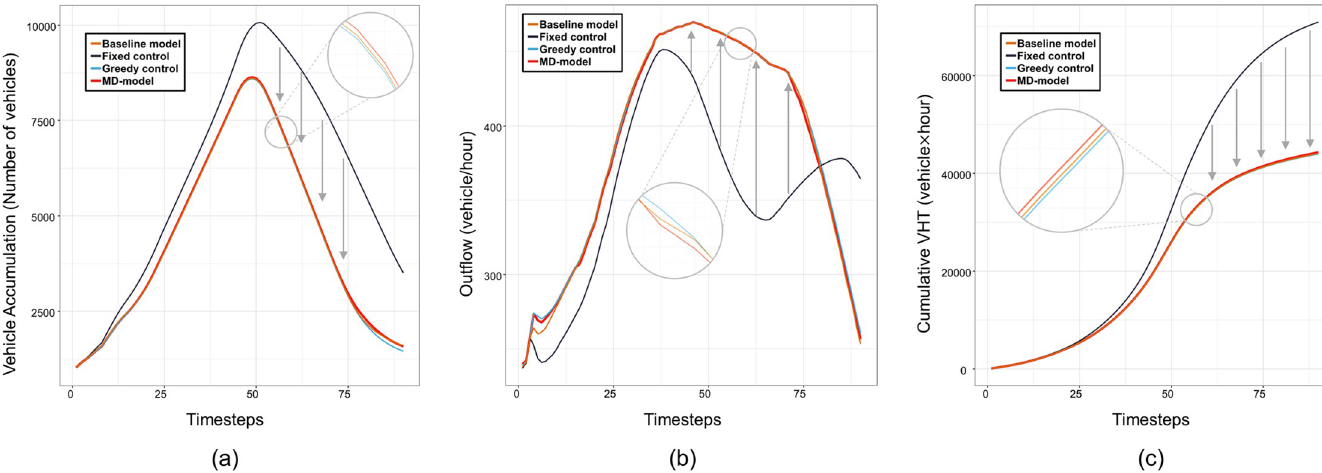
Fig 6. Model validation results of first test scenario; (a) Vehicle accumulation of network 5; (b) Outflow rate of network 5; (c) Cumulative total travel times (VHT). (Drawn by authors using R program).